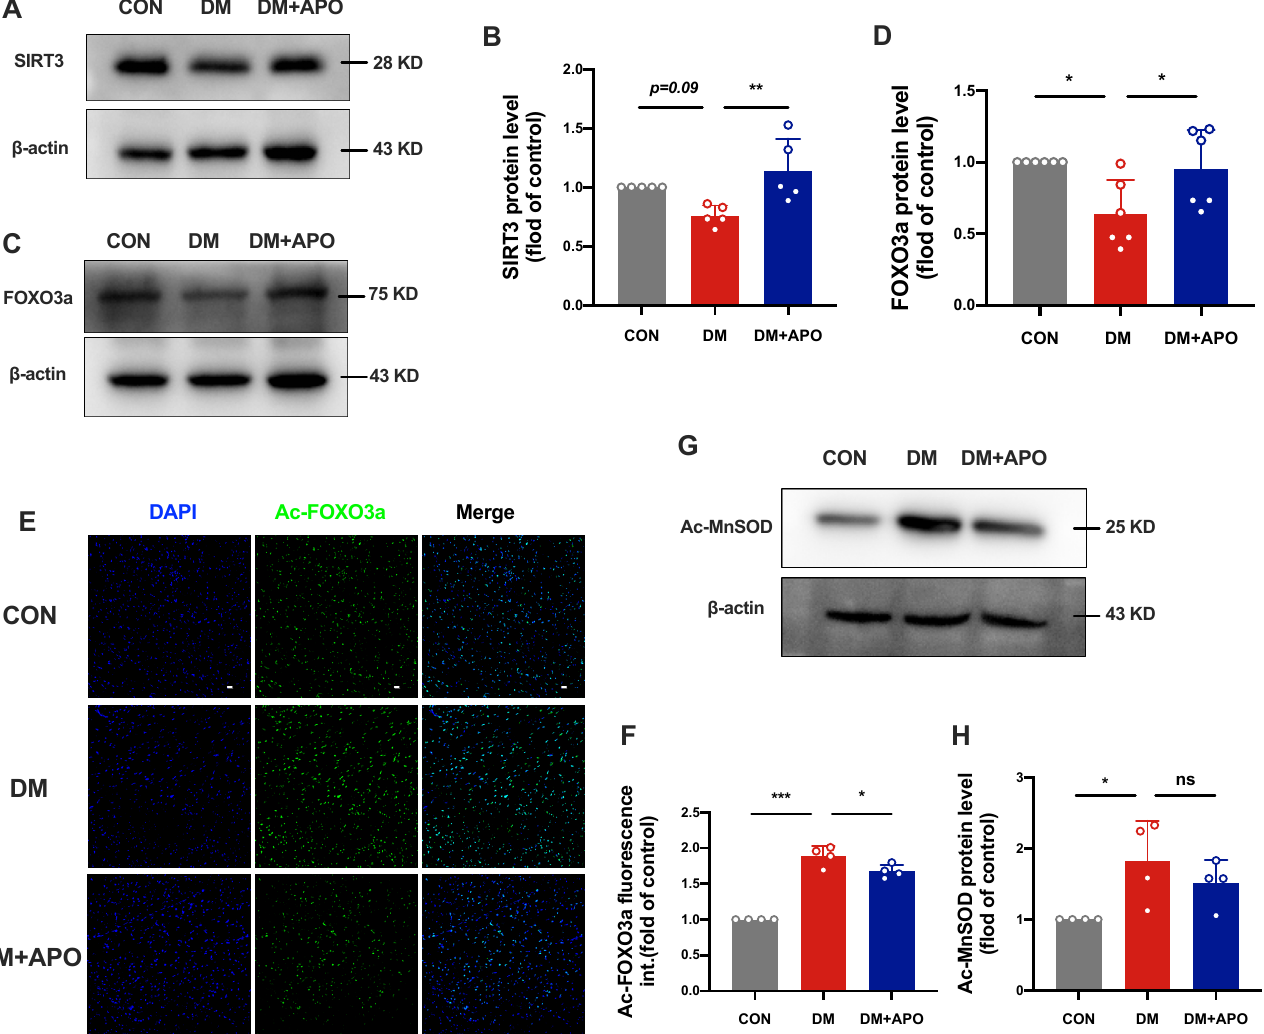
Figure 4. Apocynin regulates SIRT3/FOXO3a signaling pathway in diabetic cardiomyopathy. ( A ) Pro- tein level of SIRT3 detected by Western blot analysis. ( B ) Quantification of SIRT3 in (A). ( C ) Expression of FOXO3a in ventricular tissues. ( D ) Quantification of FOXO3a in (C). ( E ) Representative confocal microscopy images of immunofluorescence stained for Ac-FOXO3a and DAPI. ( F ) Ac-FOXO3a flu- orescence intensity quantification. Scale bar, 20 µ m. ( G ) Expression of Ac-MnSOD in ventricular tissues among 3 groups. ( H ) Quantification of Ac-MnSOD in (G). Data are mean ± SD; n = 5 mice per group; * p < 0.05, ** p < 0.01, *** p <